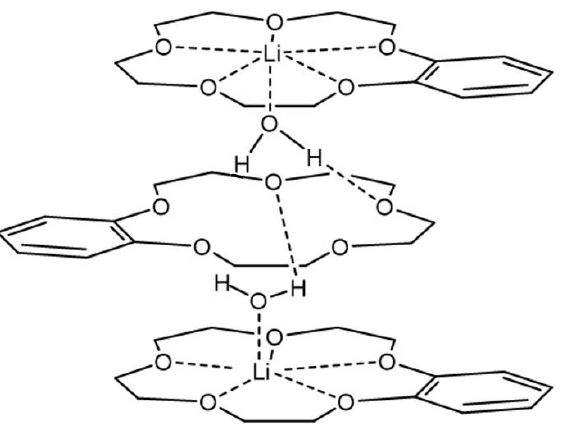
Figure 7. Scheme of the three-decked cation in (II mon ) and (II tr ) .